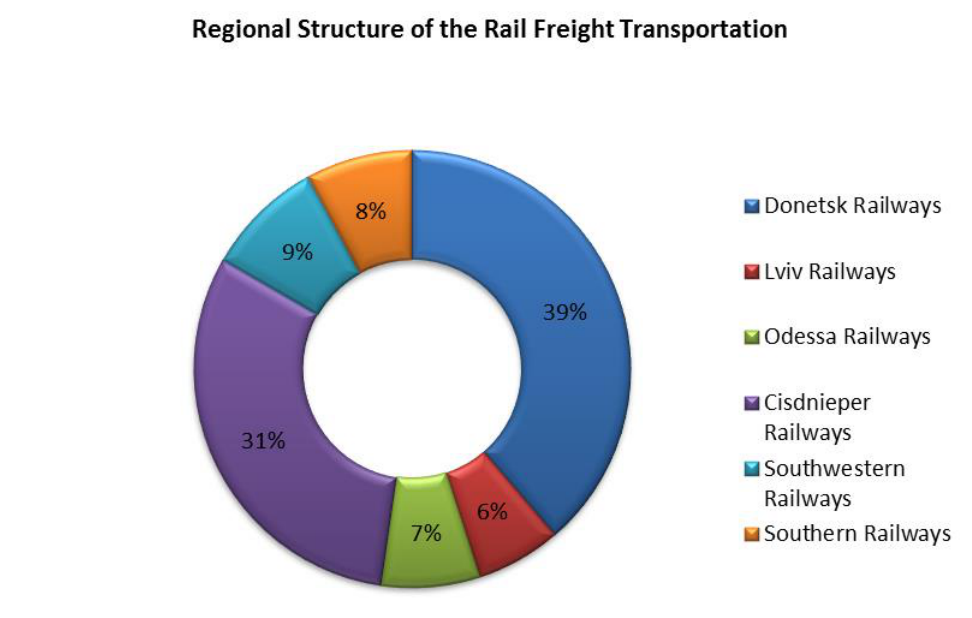
Fig. 6. Regional Structure of the Rail Freight